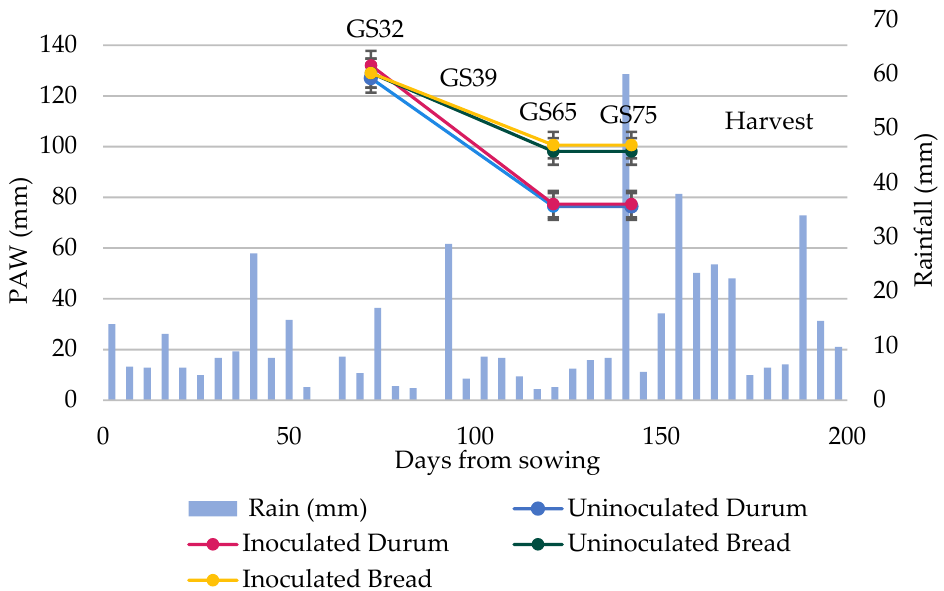
Figure 4. Plant available water (PAW) Piallamore trial site (2021) measured through neutron probes between 30–150 cm depth indicated by lines of three bread (LRPB Lancer, Suntop and LRPB Hellfire) and three durum (DBA Lillaroi, Jandaroi and DBA Aurora) wheat varieties under both inoculated and uninoculated Fusarium crown rot treatments. Error bars indicate standard error. Rainfall (>2 mm) indicated by